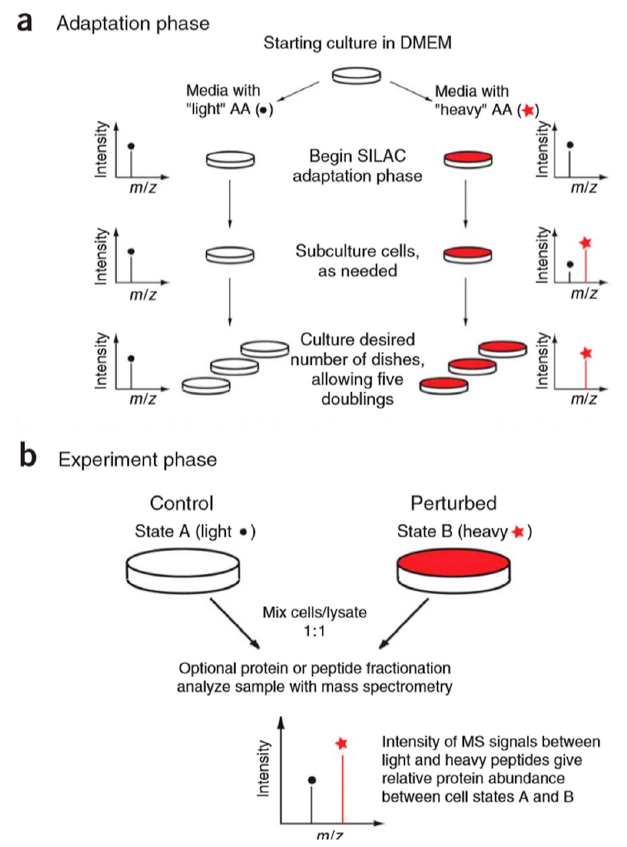
Figure 9. Overview of stable isotope labeling by amino acids in cell culture (SILAC) protocol. The SILAC experiment consists of two distinct phases: an adaptation ( a ) and an experimental ( b ) phase. This figure is adapted from reference [64].